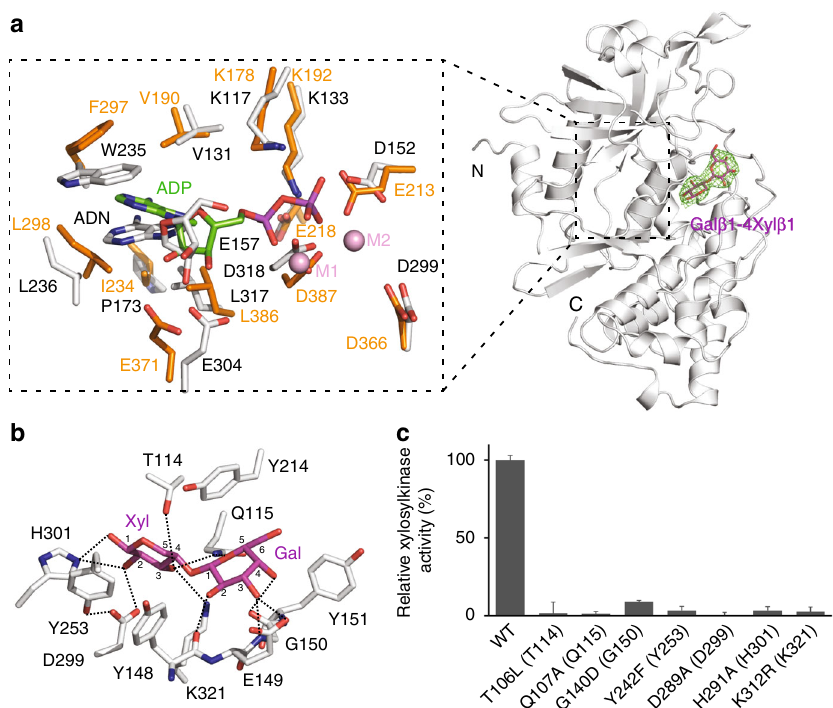
Fig. 6 Substrate recognition mechanism of Fam20B. a The structure of hmFam20 in complex with Gal-Xyl. hmFam20 is shown as white ribbons. The F o − F c difference electron density map (3.0 σ ) calculated before Gal-Xyl was modeled is shown as a green mesh, revealing the presence of the disaccharide. A close view of the ATP-binding site is displayed on the left, with the Mn/ADP-bound ceFam20 structure (shown in orange) superimposed for comparison. ADN, adenosine. The two Mn ions in ceFam20 are labeled as M1 and M2. b An enlarged image of the disaccharide-binding pocket showing the detailed molecular interactions between hmFam20 and Gal-Xyl. c Human Fam20B mutants display reduced or abolished kinase activity. The amino acids in brackets indicate the corresponding residues in hmFam20. Error bars represent the standard deviation of three independent